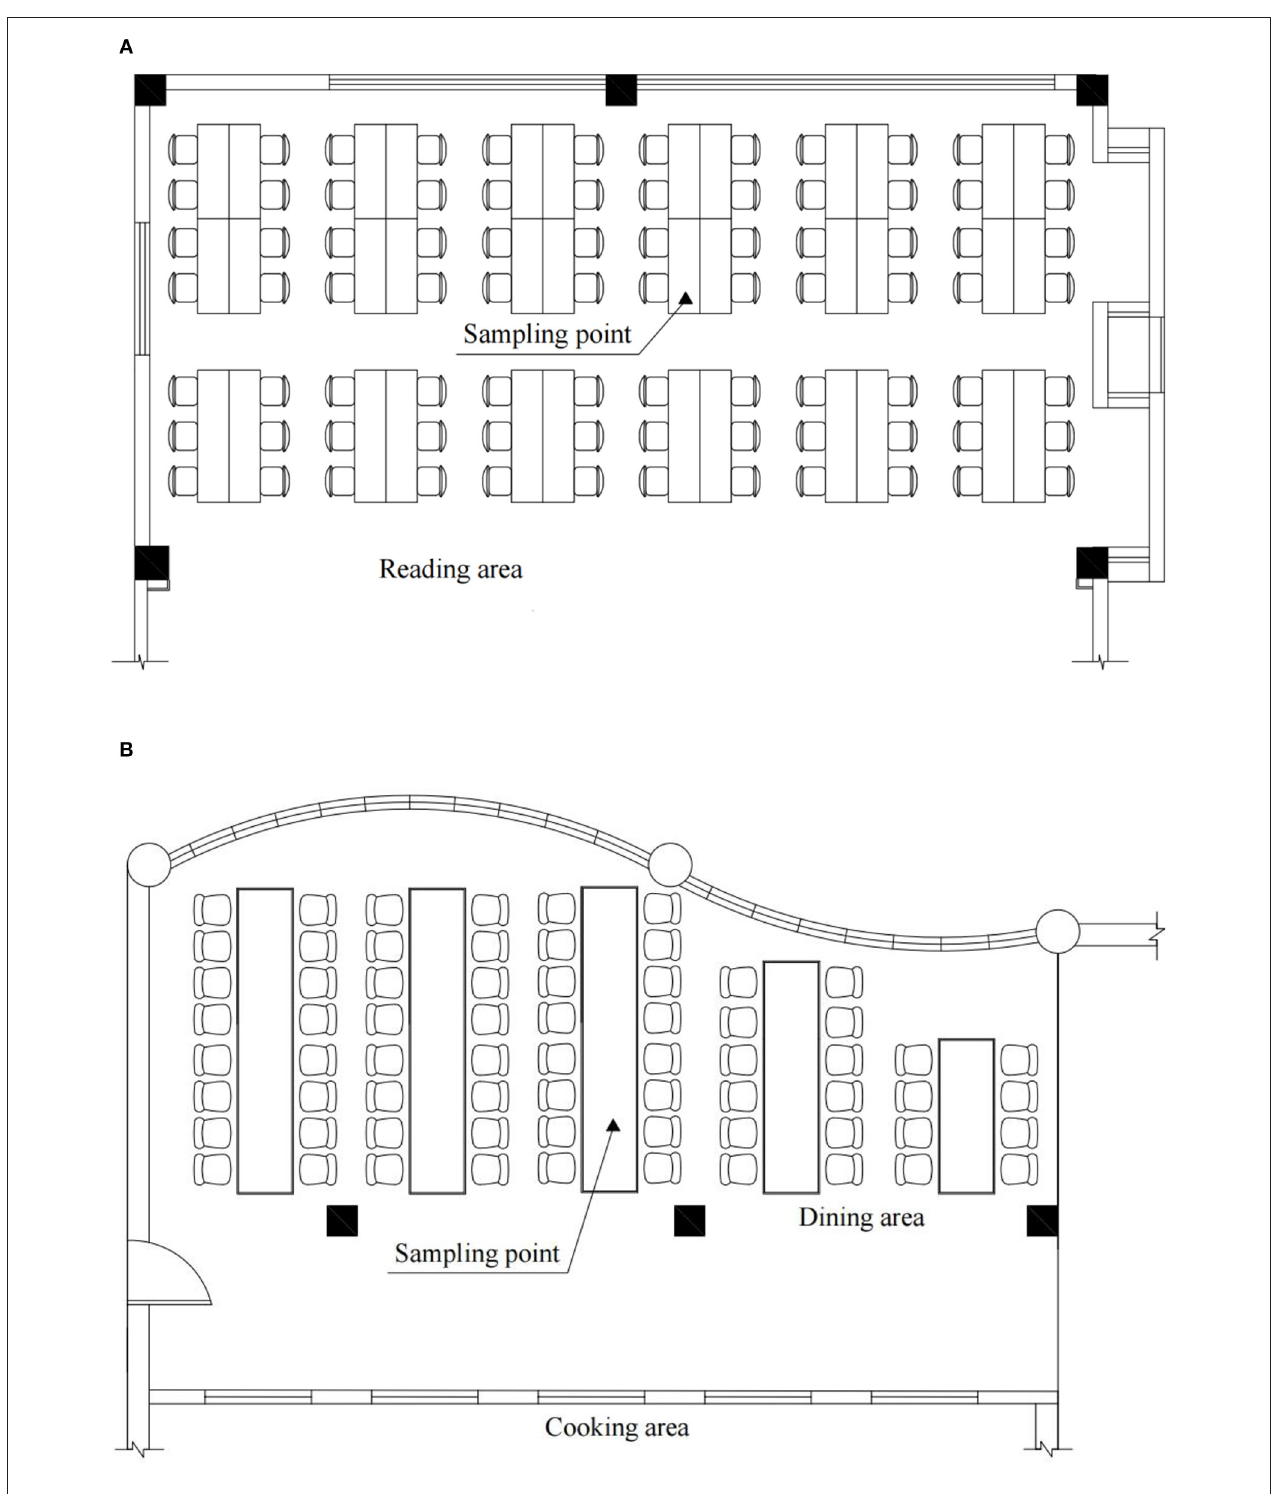
FIGURE 1 | Indoor measuring points in the library (A) and canteen (B) .